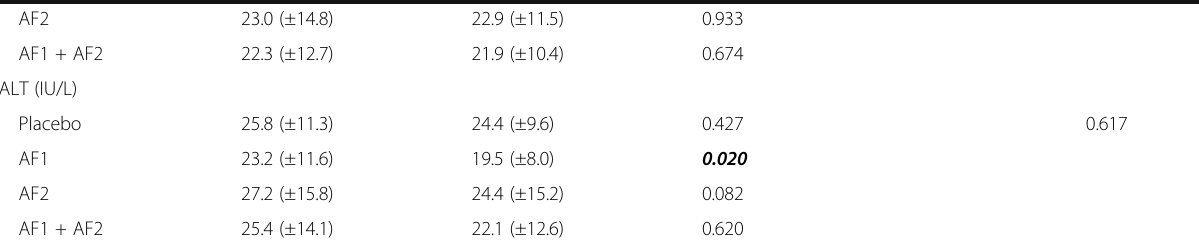
Table 10 Changes in metabolic measures from day − 14 to day 84 (Continued)